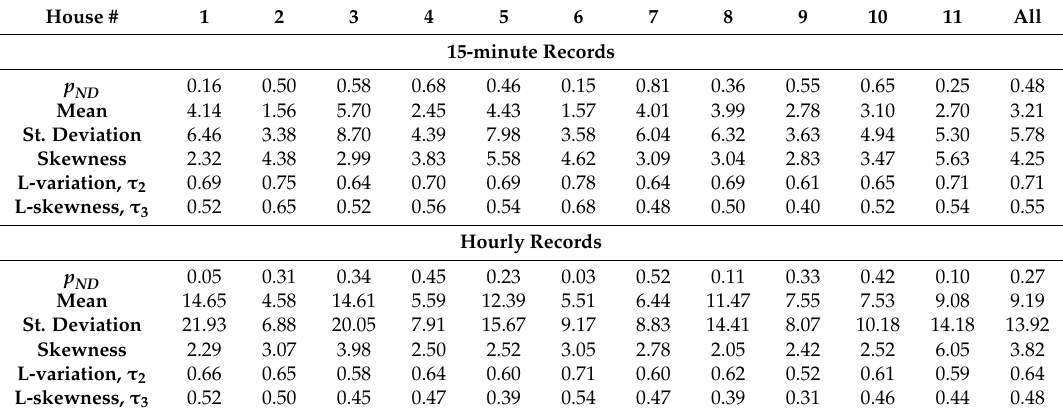
Table 2. Basic summary statistics of the nonzero 15-minute and hourly per capita demand records. House